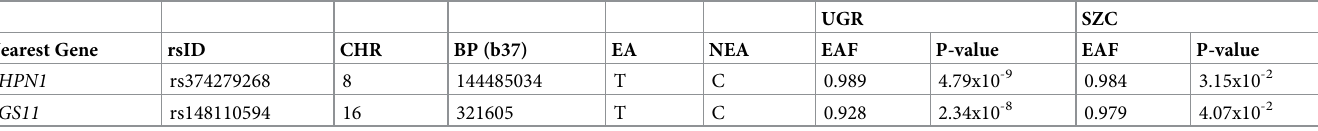
Table 2. Lead SNPs in UGR that replicated in SZC. Nearest Gene